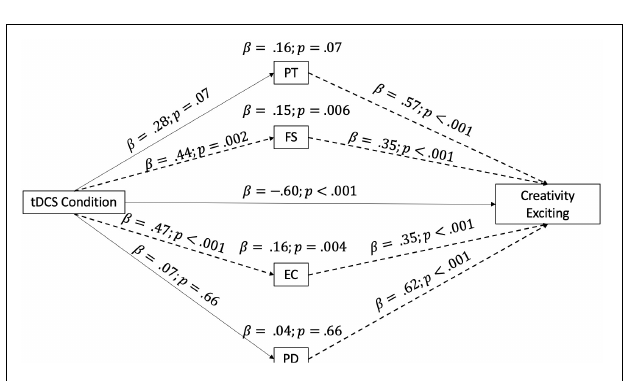
FIGURE 2 | Mediation model taking into consideration the IRI subscales as mediators of the relationship between the tDCS condition and the evaluation of creativity/excitement. The arrow indicates the direction of the mediation, and the dotted lines highlight significant mediation effects. IRI subscales: PT, perspective taking; FS, fantasy; EC empathic concern; PD personal distress.